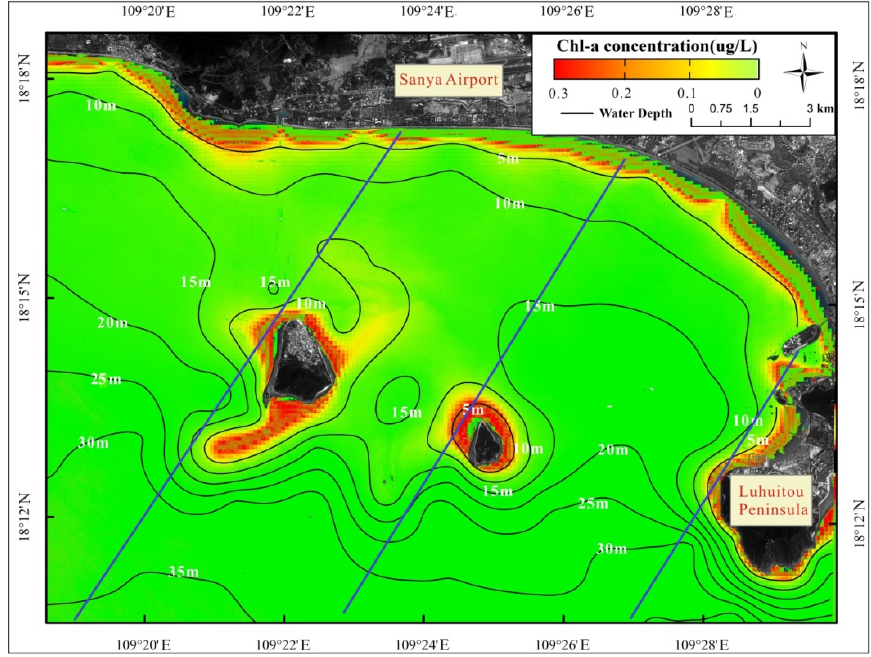
Figure 16. The difference between the results retrieved by R rs and those by r rs .